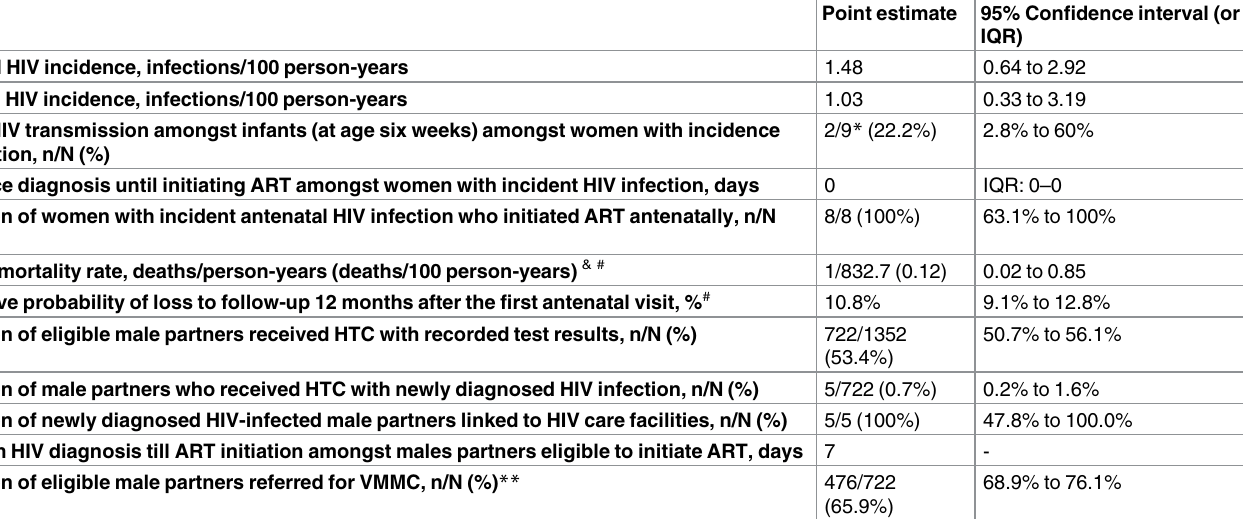
Table 3. Secondary study outcomes evaluating a combination HIV prevention intervention amongst pregnant and postpartum women in South Africa.